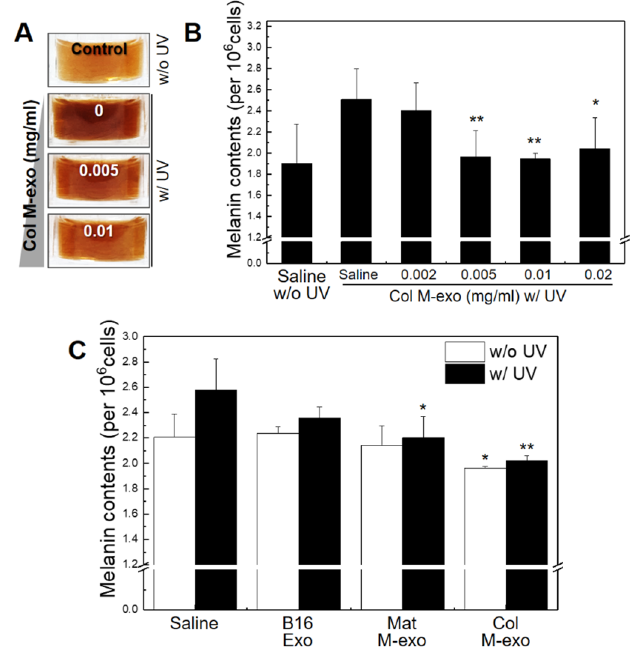
Figure 4. Inhibitory effect of Col M-exo on melanogenesis in B16F10s. ( A ) Image of extracting intracellular melanin from cells irradiated with UV after pre-treating cells with Col M-exo. ( B ) Melanin contents of cells irradiated with ultraviolet rays after pre-treating with Col M-exo at a concentration of 0.002, 0.005, 0.01, and 0.02 mg/mL, n = 3; * p < 0.05, ** p < 0.01, versus saline with UV. ( C ) Melanin contents of cells irradiated with UV after pre-treating with each type of exosome at concentrations of 0.01 mg/mL, n = 3; * p < 0.05, ** p < 0.01, versus saline.